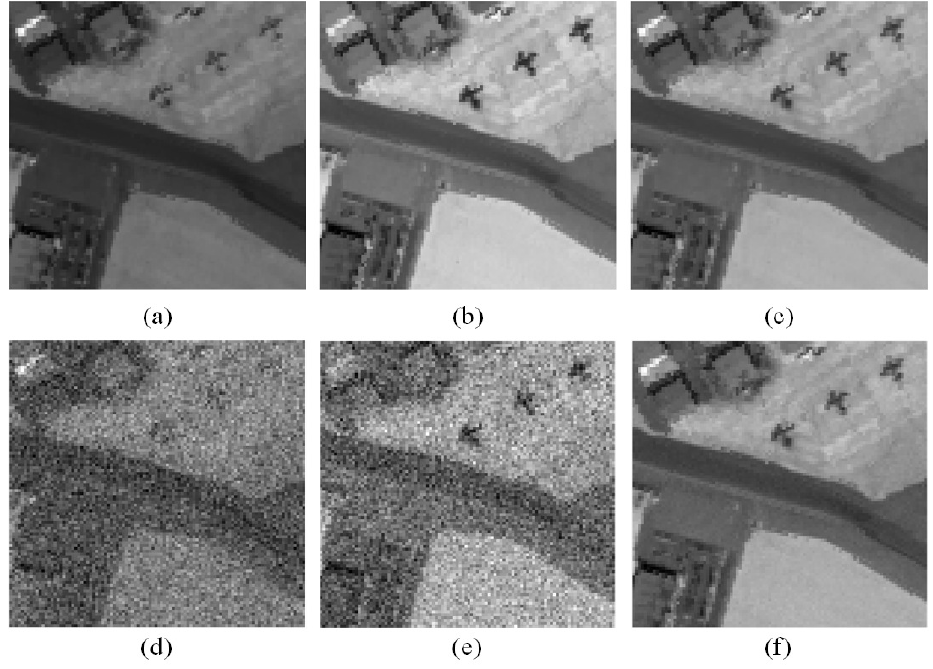
Figure 1. Visual comparison of different spectral channels in experimental dataset: ( a ) The 20th channel of AVIRIS-I; ( b ) the 150th channel of AVIRIS-I; ( c ) the first principal component map of AVIRIS-I; ( d ) the corresponding Gaussian noise image of ( a ); ( e ) the corresponding Gaussian noise image of ( b ); ( f ) the corresponding Gaussian noise image of ( c